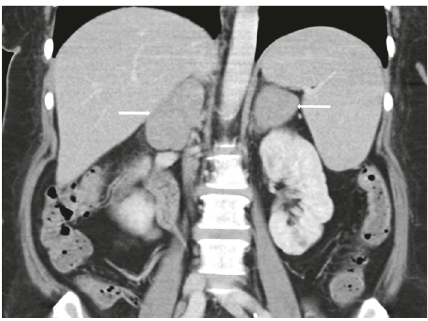
Figure 2: At the time of diagnosis. Imaging studies of patient, CT thorax, and abdomen and pelvis show bilateral adrenal masses which are homogenous measuring 3.7 × 5.4 × 6.3 cm on the left (78.3 average HU), while the right adrenal gland measures 5.5 × 2.7 × 5.9 cm (72.7 average